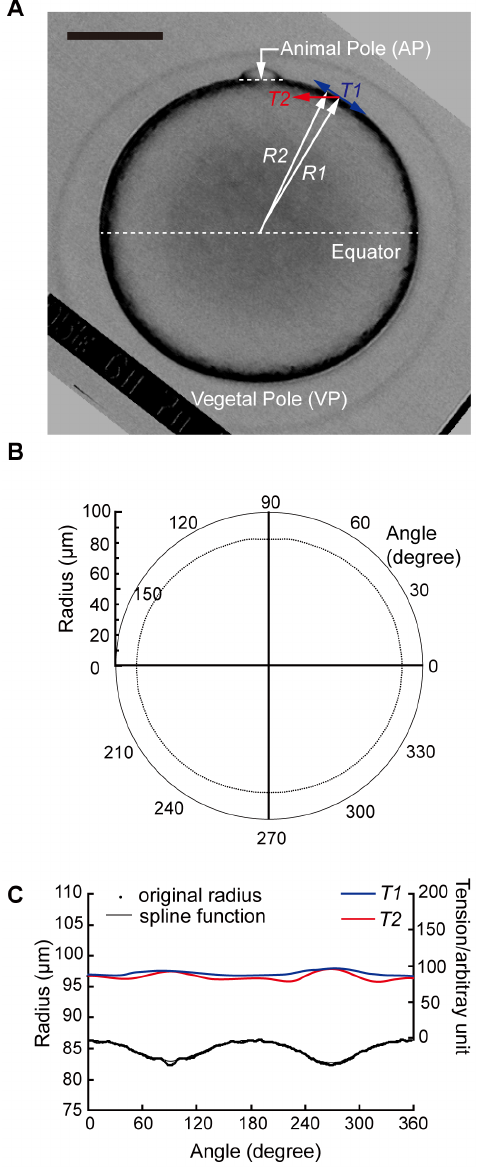
Figure 1. Procedure of rough estimation of the tension at the surface of whole oocytes. (A) Image of an oocyte at low resolution. Tension at the surface in the longitudinal direction (the direction joining pole to pole), T1 , that in the latitudinal direction (the direction at right angles to the former), T2 , and principal radii of curvature, R1 and R2 are indicated. Scale bar, 50 m m. (C) Binary image of the oocyte in (A) processed by NIH-Image, and the outline curve of the oocyte expressed in polar coordinates. (D) The radius of the oocyte and the tensions at the surface. The spline function accurately fits the radius of the original outline curve except for the animal